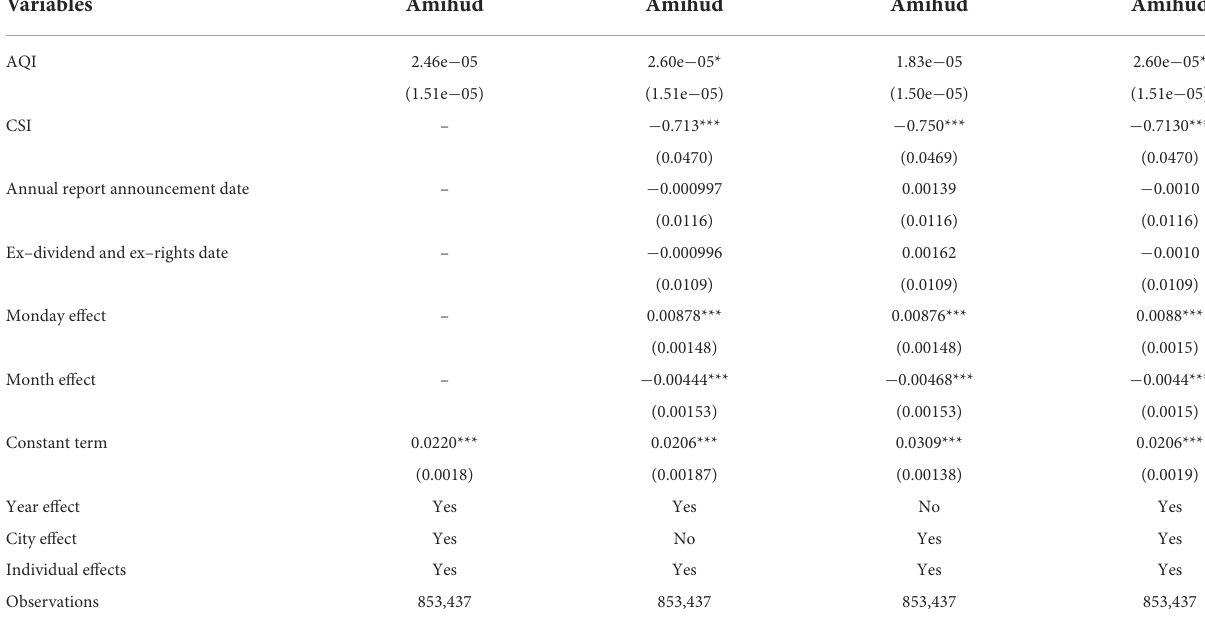
TABLE 8 Regression results of Amihud on